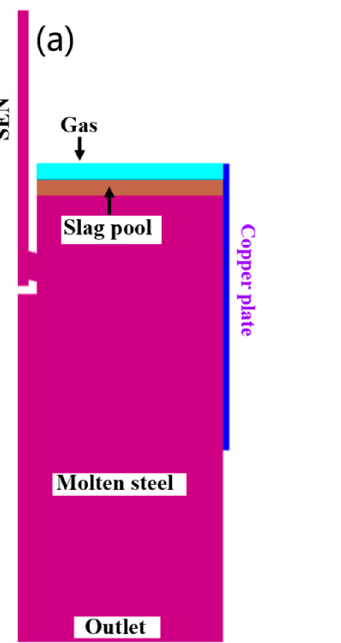
Figure 2. Schematic of ( a ) mold model and ( b ) mesh of computation domain.